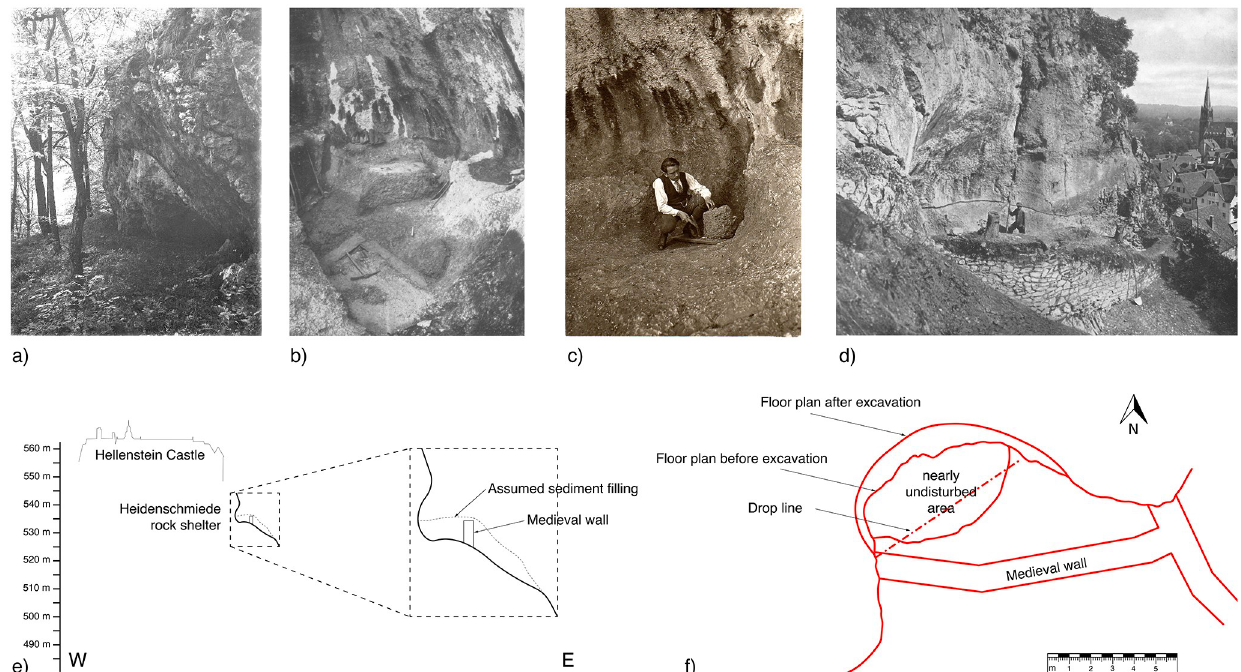
Fig 3. Images of Heidenschmiede. Legend: a) Rock shelter before excavation in 1930 (G. Odenwald); b) Rock shelter during excavation in 1930 [103]; c) Hermann Mohn during excavation in 1930; d) Rock shelter with medieval wall during excavation in 1930 [103: Taf. III1]; e) Altitude of the Hellenstein castle and the Heidenschmiede (section along the slope at Heidenschmiede redrawn from [103: Taf. II2]) and f) floor plan of Heidenschmiede, redrawn from [103: Taf. II1].